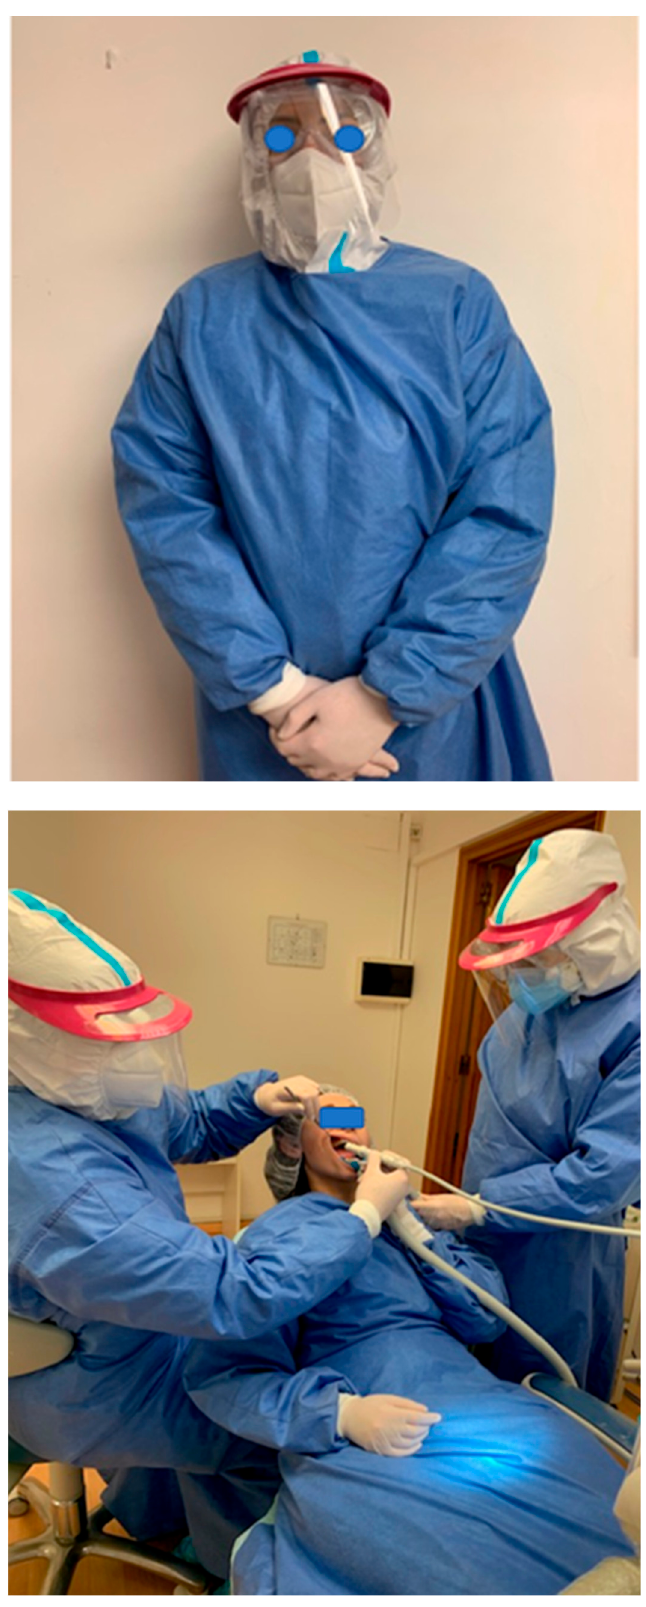
Figure 8. Personal protective equipment.